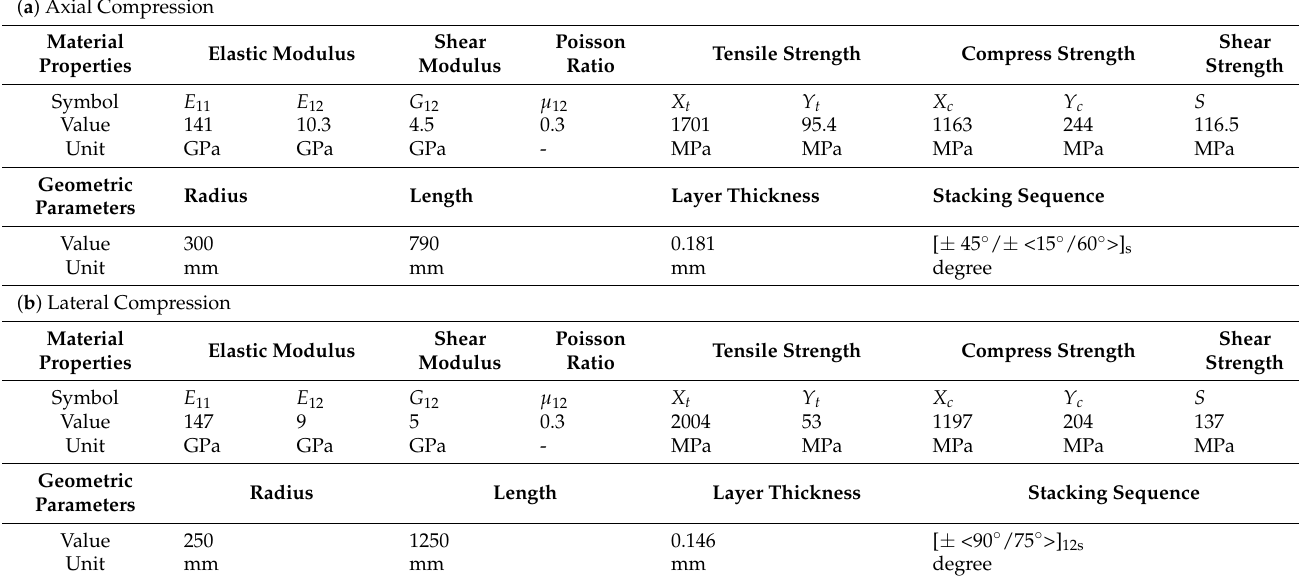
Table 1. Material properties and geometric parameters for different test cases: ( a ) axial compression and ( b ) lateral